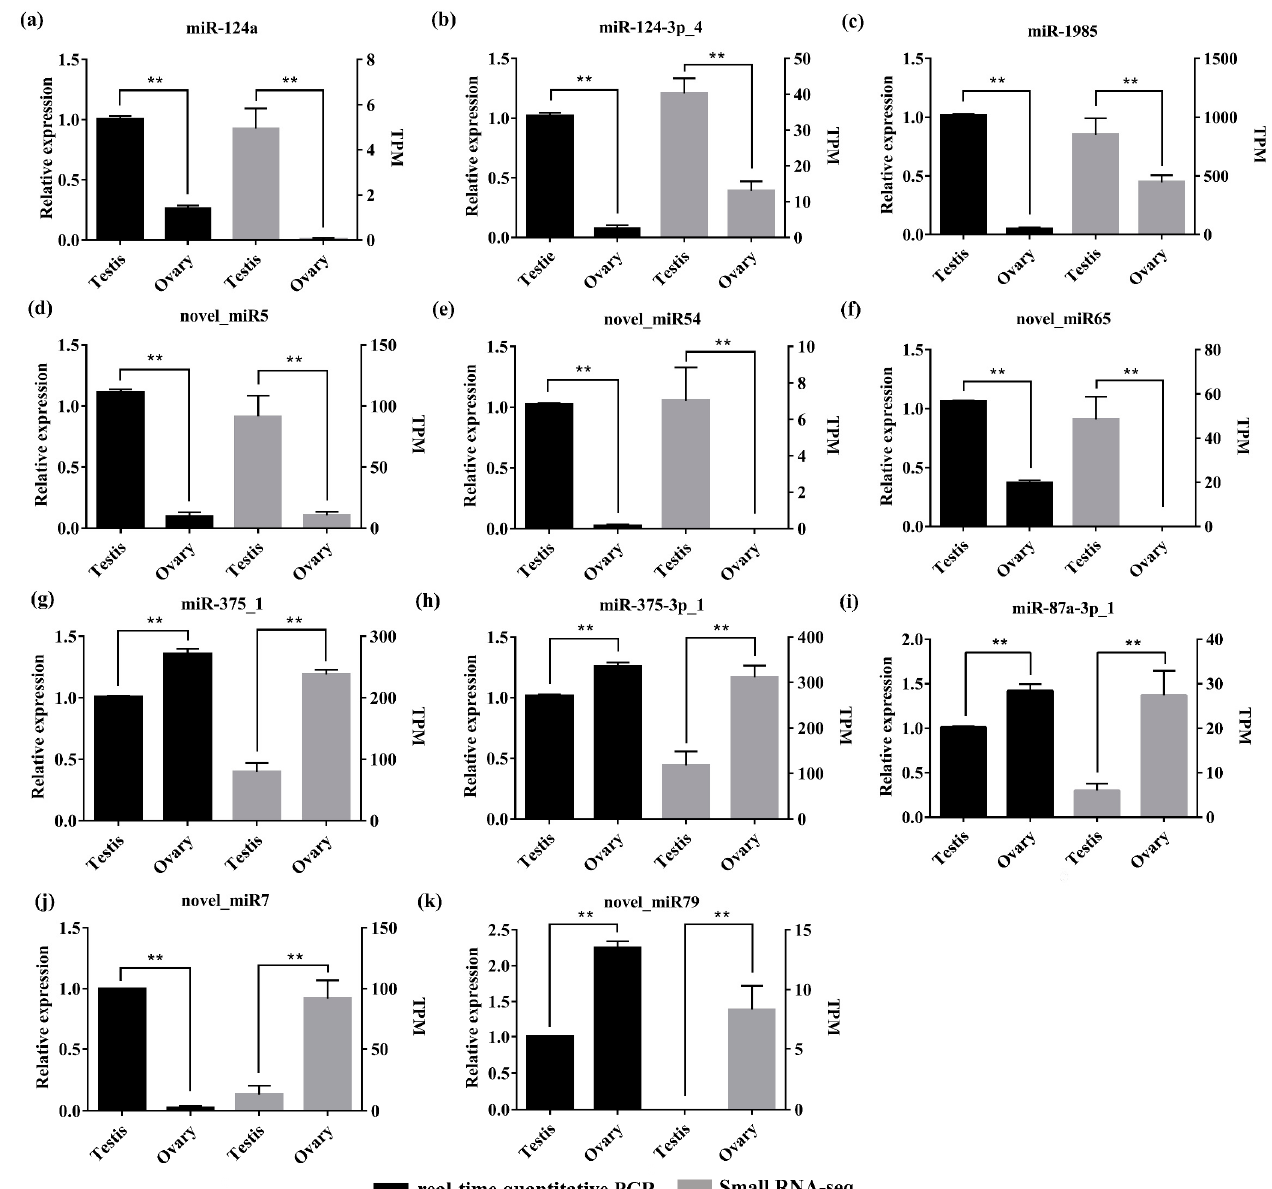
Figure 6. The relative expression of different miRNAs detected by RT-qPCR (left) and small RNA transcriptome data (right). (a)–(f): six testis-biased miRNAs (miR-124a, miR-124-3p_4, miR-1985, novel_miR5, novel_miR54, and novel_miR65); (g)–(k): five ovary-biased miRNAs (miR-375_1, miR-375-3p_1, miR-87a-3p_1, novel_miR7, and novel_miR79). miRNAs expression in the testis were set to “1.00” to calibrate the relative expression. Values are presented with means ± SD ( n = 3). Asterisks (**), p < 0.01.